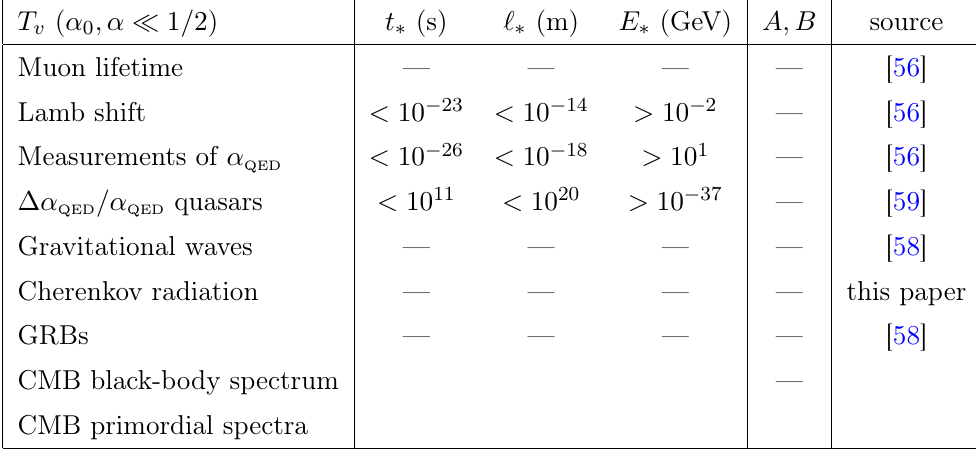
Table 4 . Absolute bounds on the hierarchy of multifractional spacetimes with weighted derivatives (obtained for (cid:11) 0 ; (cid:11) (cid:28) 1 ). All figures are rounded. Items “—” are cases where the theory gives the standard result or where the experiments listed in the table are unable to place significant constraints. Empty cells are cases not explored